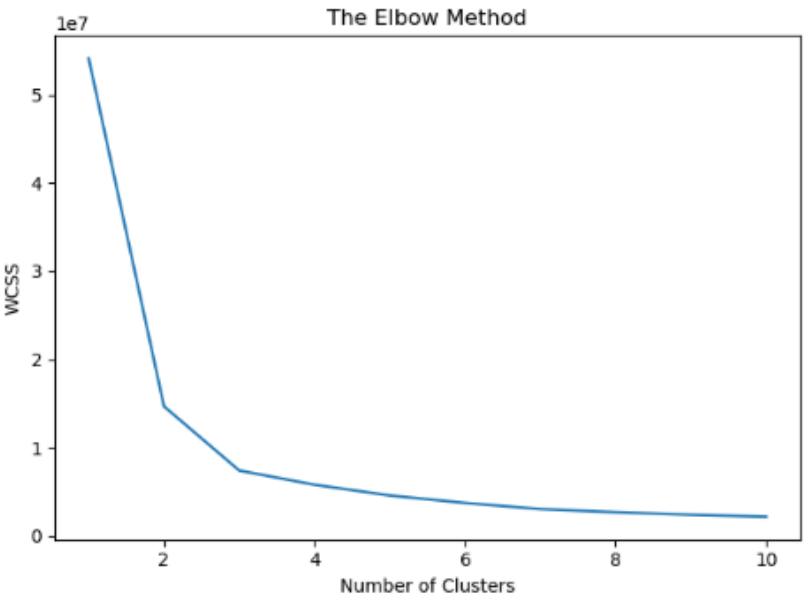
Figure 6. Elbow method result for clustering purposes of batch data of fleet